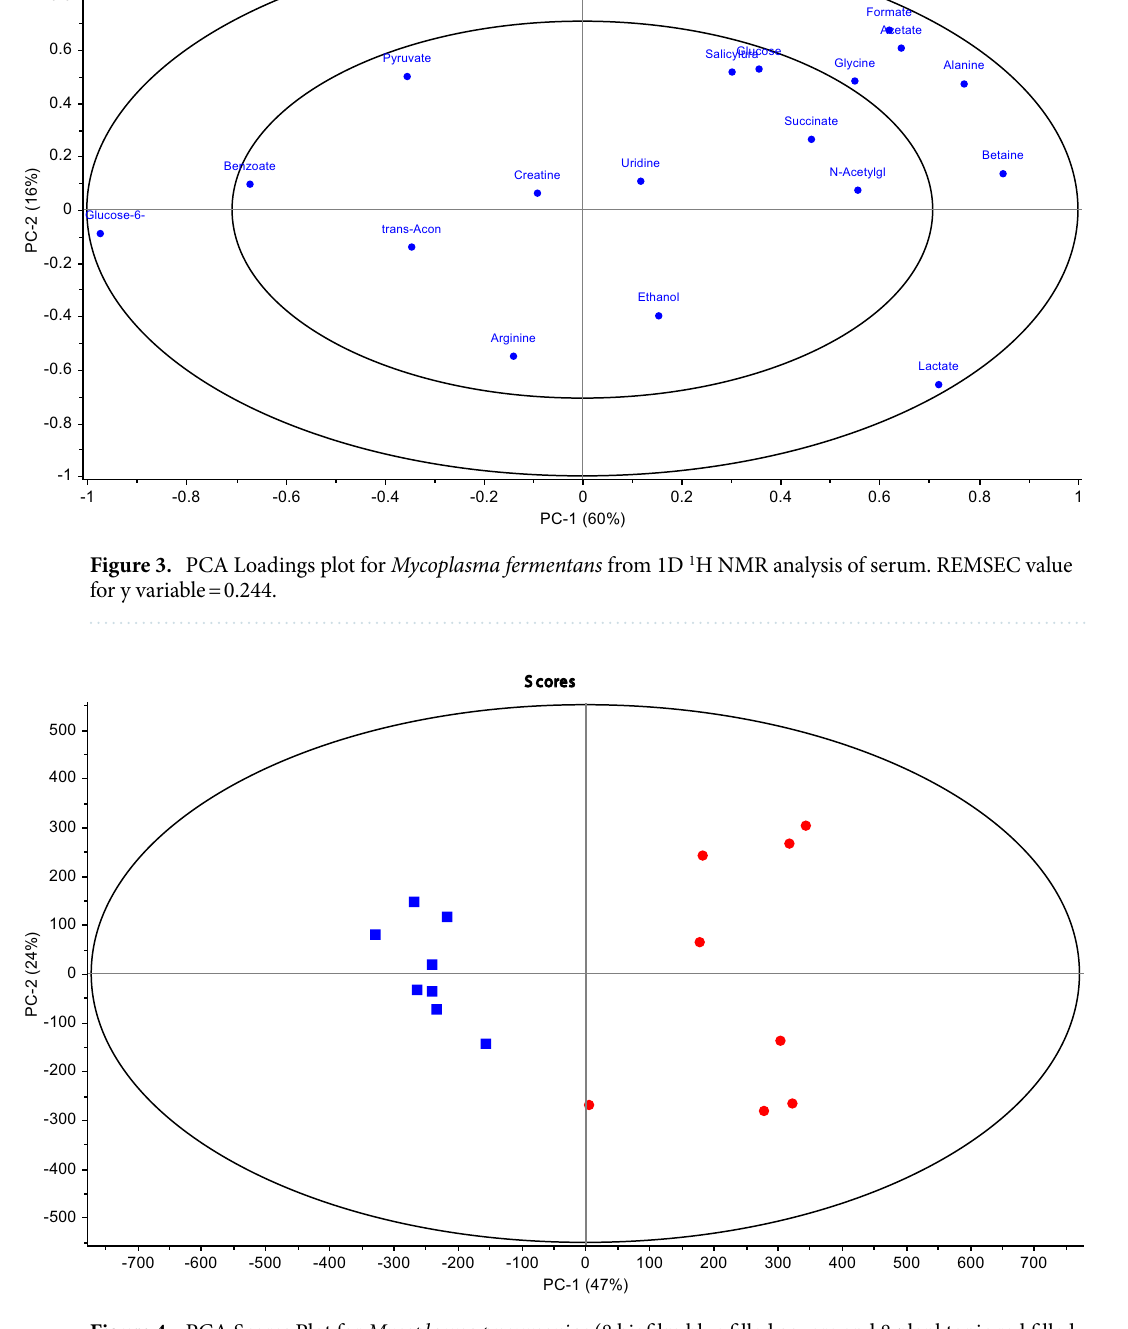
Figure 4. PCA Scores Plot for Mycoplasma pneumoniae (8 biofilm blue filled square and 8 planktonic red filled circle samples) from 1D 1 H NMR analysis of